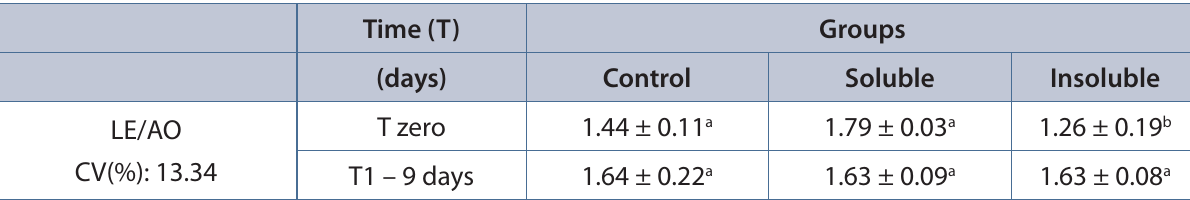
Table 11. Left atrium:aorta ratio (LA/AO) in rabbits submitted to gavage with ultra-pure water (CG), water- soluble A. rigida extract (SG) and water-insoluble A. rigida extract (IG) at different